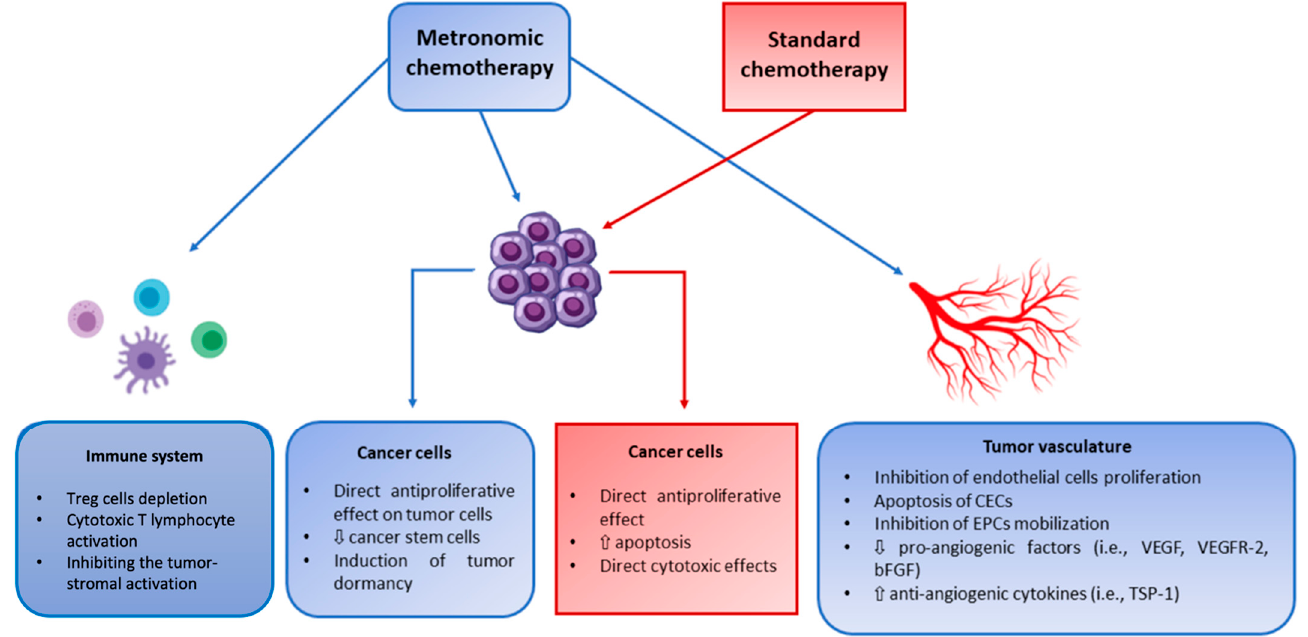
Figure 1. Mechanism of action of metronomic chemotherapy versus standard chemotherapy. bFGF; basic fibroblast growth factor, CEC; circulating endothelial cell, EPC; endothelial progenitor cell, TSP- 1; thrombospondin-1, T reg ; regulatory T cells, VEGF; vascular endothelial growth factor. Reproduced with slight modification and permission from